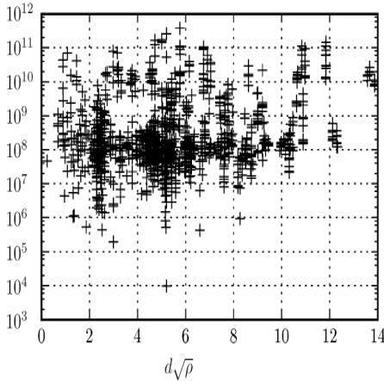
Prefactor C as a function of smallest outer sample dimension d and square root of the dislocation density ϱ. Measured from the deposition of dislocation density on zero SCHMID factor systems in Discrete Dislocation Dynamics (DDD) simulations. Figure adopted from with permission from KIT Scientific Publishing. Licensed under CC BY-SA 4.0.